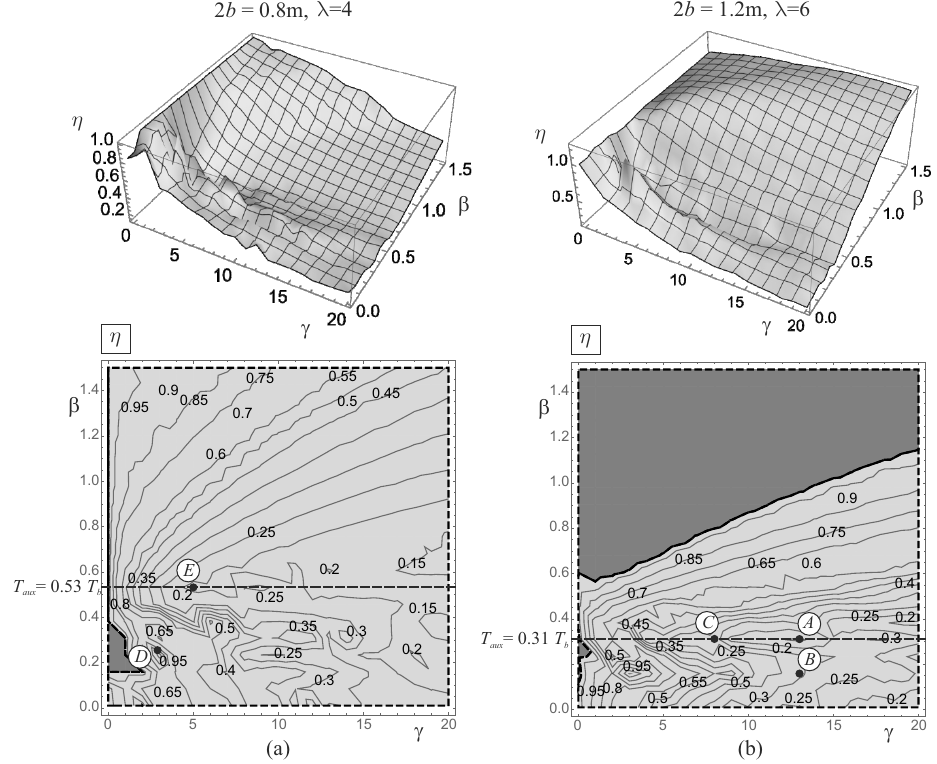
Figure 8. Gain surfaces (top graphs) and maps (lower graphs) for the Kobe seismic record: ( a ) di- mensions of the rigid block 2 b = 0.8 m and λ = 4 ( r = 0.9118); ( b ) dimensions of the rigid block 2 b = 1.2 m and λ = 6 ( r = 0.9595), ( m = 0.05 M , u y = 1/3 u cr , ψ = 0.2)